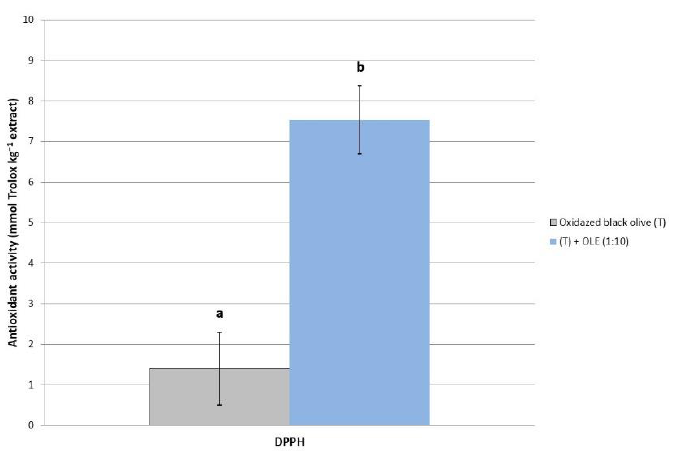
Figure 2. Antioxidant activity of ‘Hojiblanca’ variety with the addition of ‘Sayali’ aqueous extract.